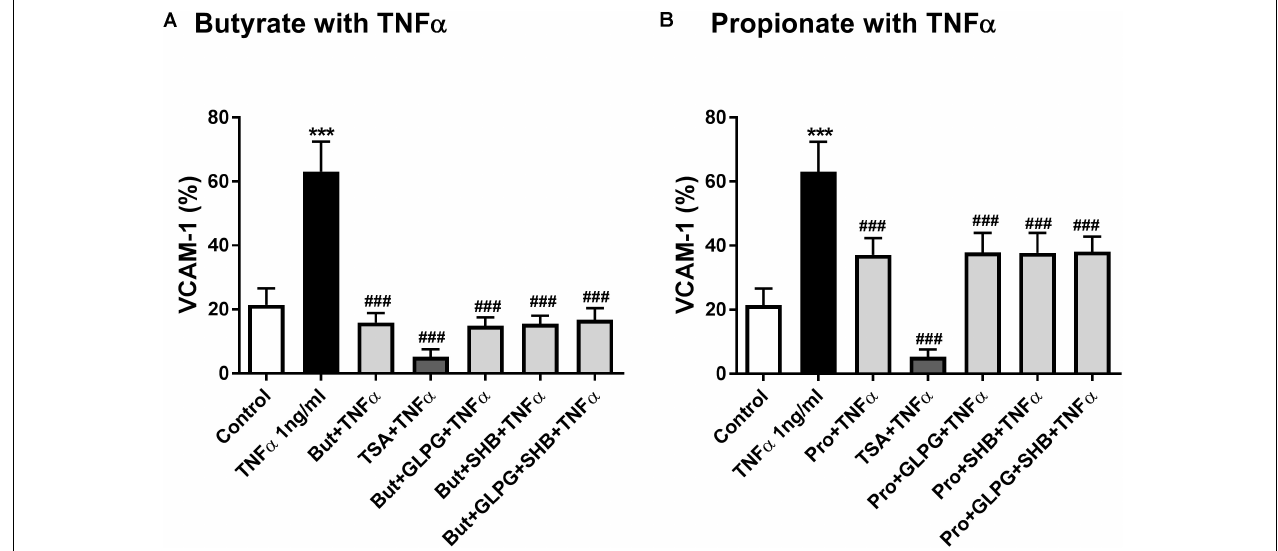
FIGURE 5 | Butyrate and propionate inhibited TNF α -induced VCAM-1 expression. HUVEC were pre-treated with propionate (10 mM), butyrate (5 mM), GLPG (0.1 µ M), SHB (5 mM), TSA (1 µ M), or their combinations and then exposed to TNF α (1 ng/mL). (A) Shows the effects of butyrate or its combination with GLPG and/or SHB on VCAM-1 expression; (B) shows the effects of propionate or its combination with GLPG and/or SHB on VCAM-1 expression. N = 5. ∗∗∗ p < 0.001 compared with control group; ### p < 0.001 compared with TNF α group.